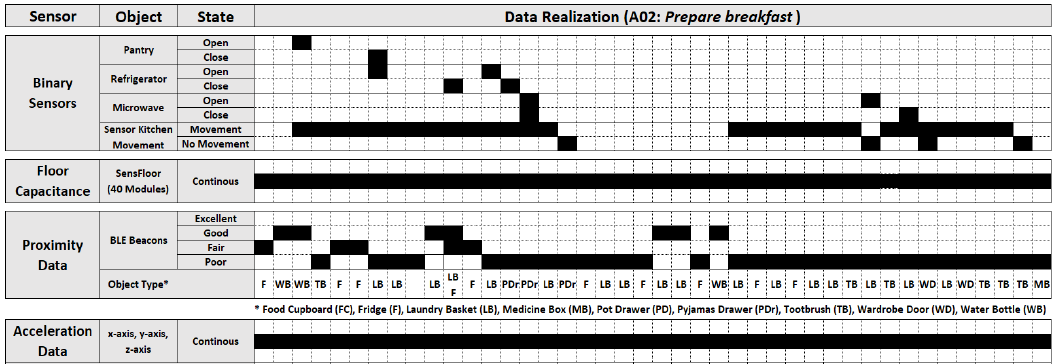
Figure 1. Time series analysis for example Prepare breakfast in UCamI dataset